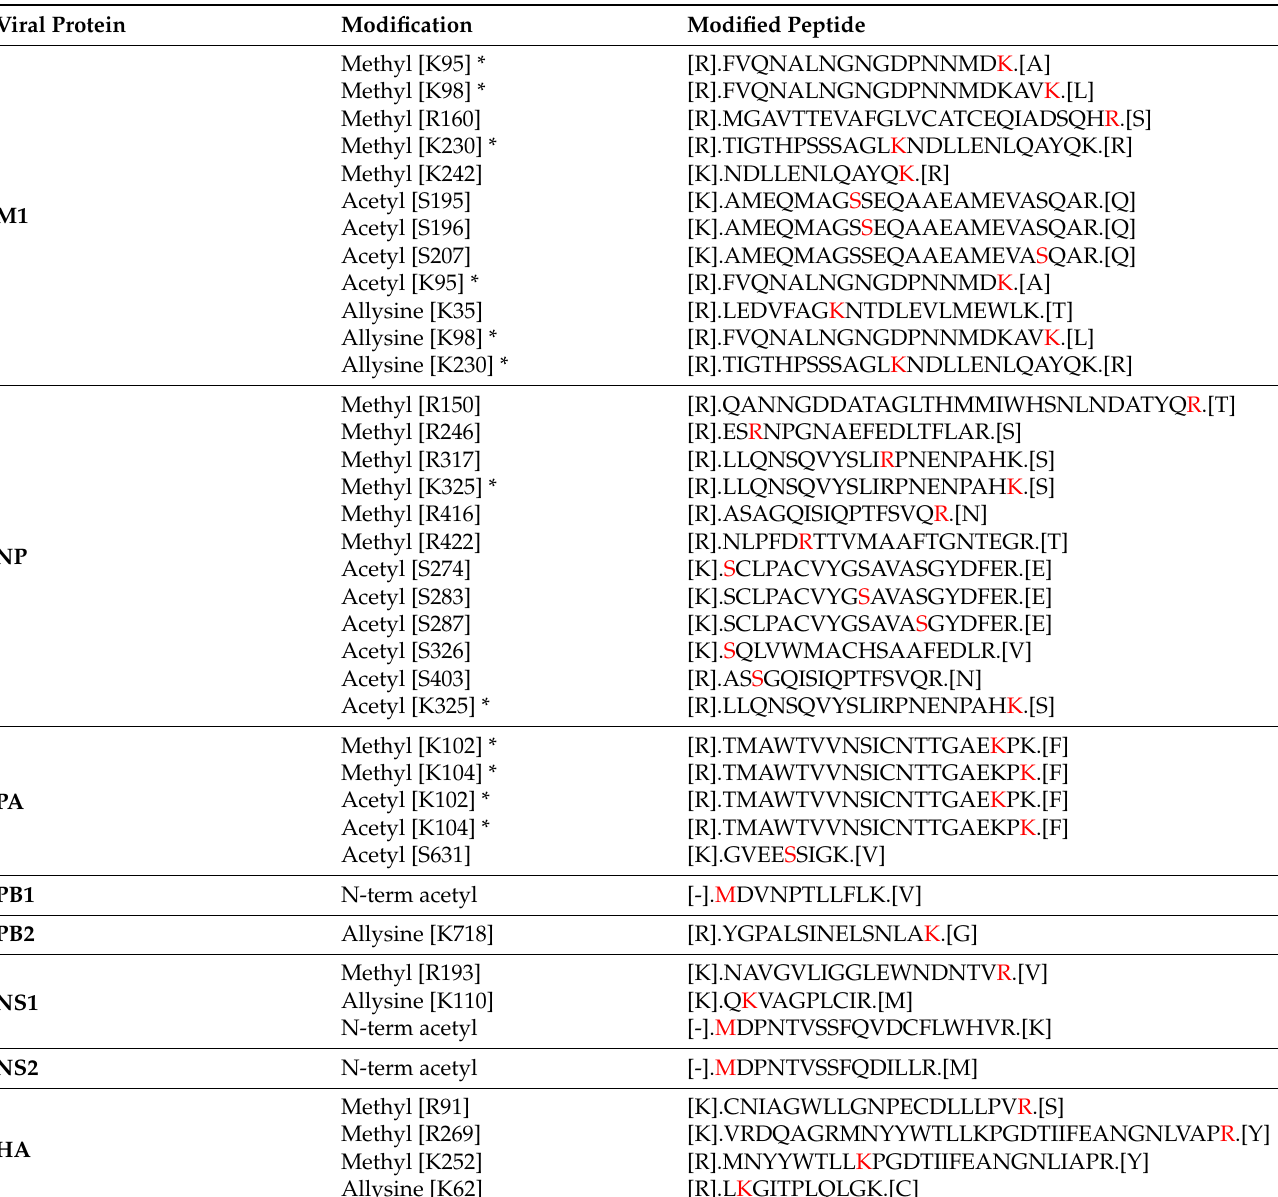
Table 1. Identified methylated, acetylated, and allysine sites in major influenza A virus (IAV) proteins. Viral